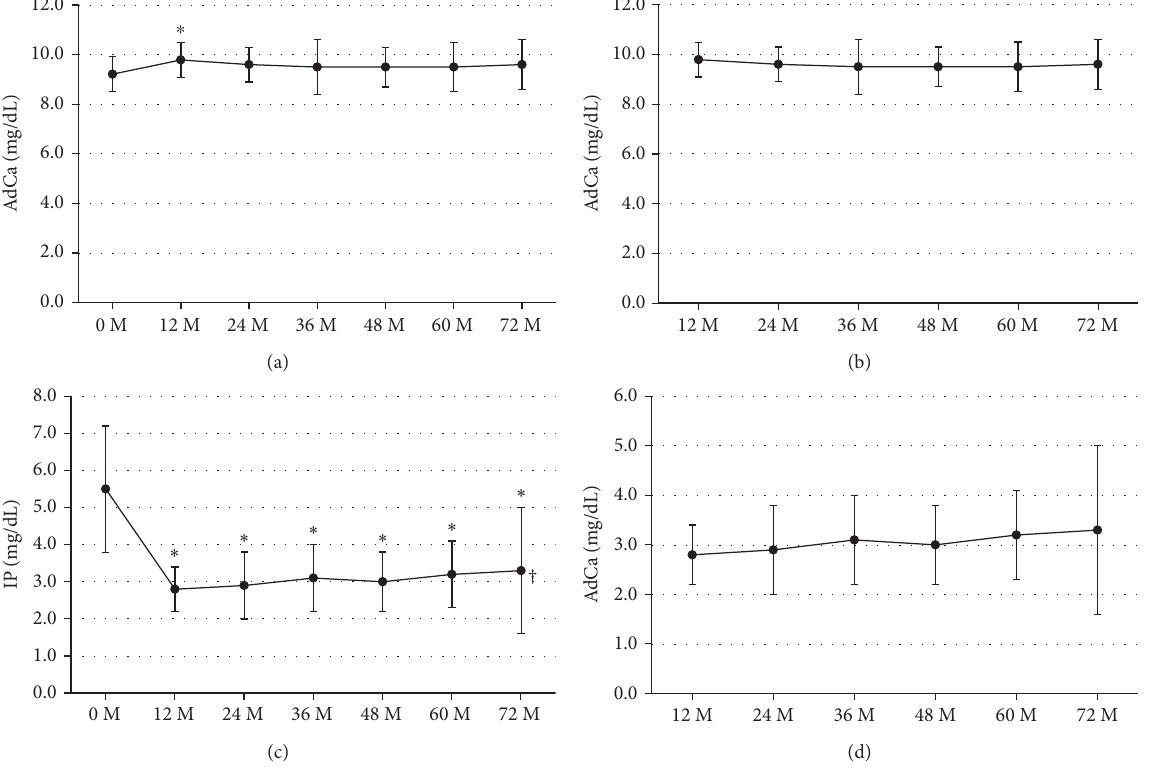
Figure 3: Levels of adjusted serum Ca (AdCa, mean ± SE) at baseline and at 12, 24, 36, 48, 60, and 72 months following renal transplantation (a) at 12, 24, 36, 48, 60, and 72 months (b), levels of IP (mean ± SD) at baseline and at 12, 24, 36, 48, 60, and 72 months following renal transplantation (c) at 12, 24, 36, 48, 60, and 72 months (d). Patients who received parathyroidectomy were excluded. AdCa, adjusted serum calcium; IP, inorganic phosphorus. ∗ P value < 0.05 vs. 0 M, Tukey’s test. ∗∗ P value < 0.05 vs. 12 M, Tukey’s test. † P value < 0.05, multivariate repeated-measures approach.